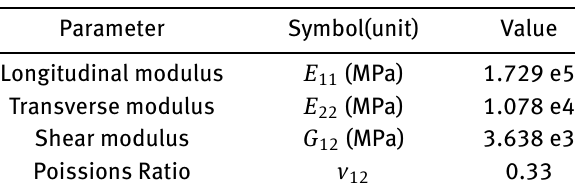
Table 1: Mechanical properties of carbon fiber reinforced composite